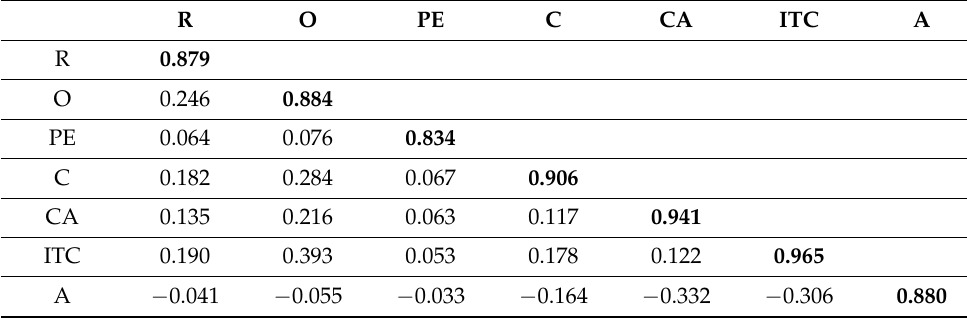
Table 4. Discriminant